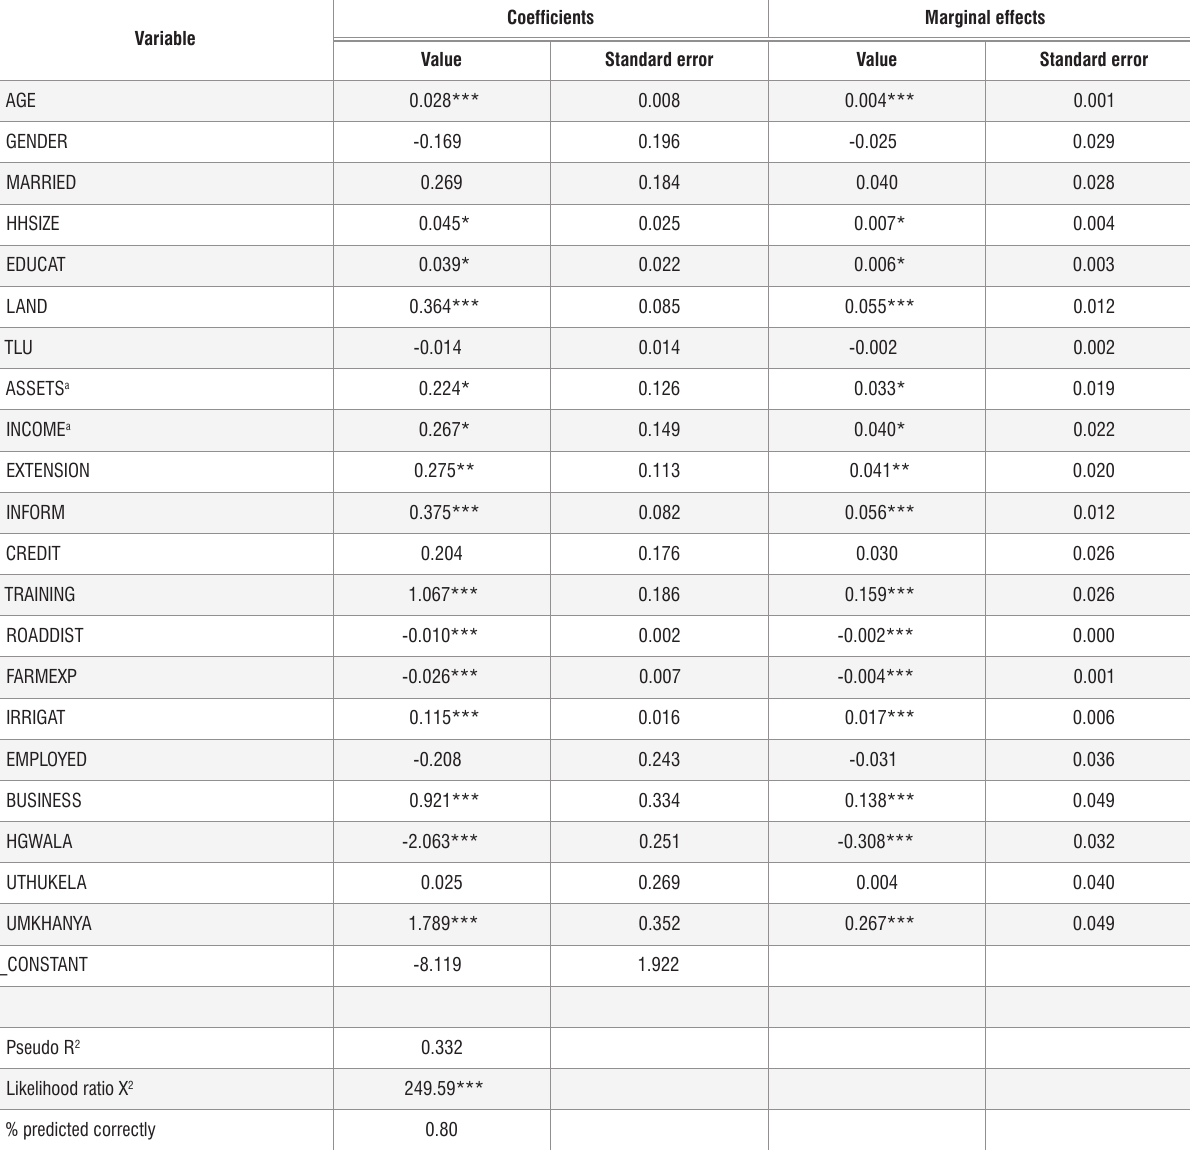
Table 3: Factors determining farmer group membership: logit model